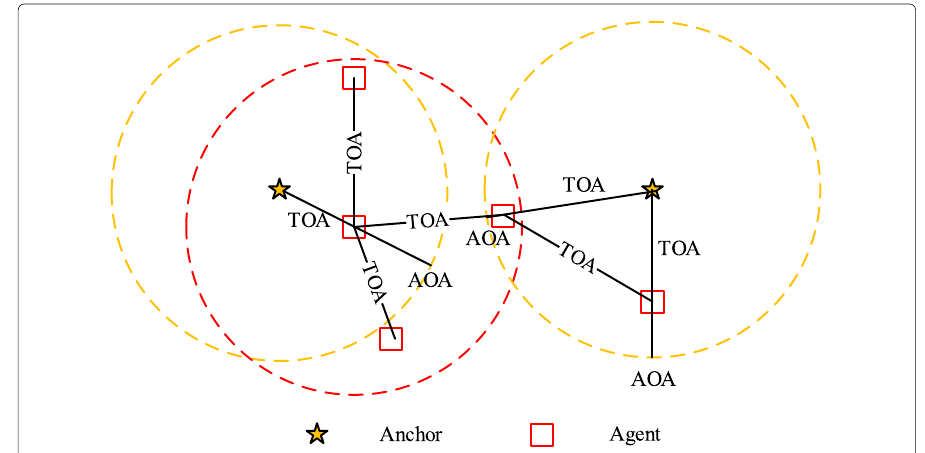
Fig. 1 Single anchor-based cooperative localization in mmWave